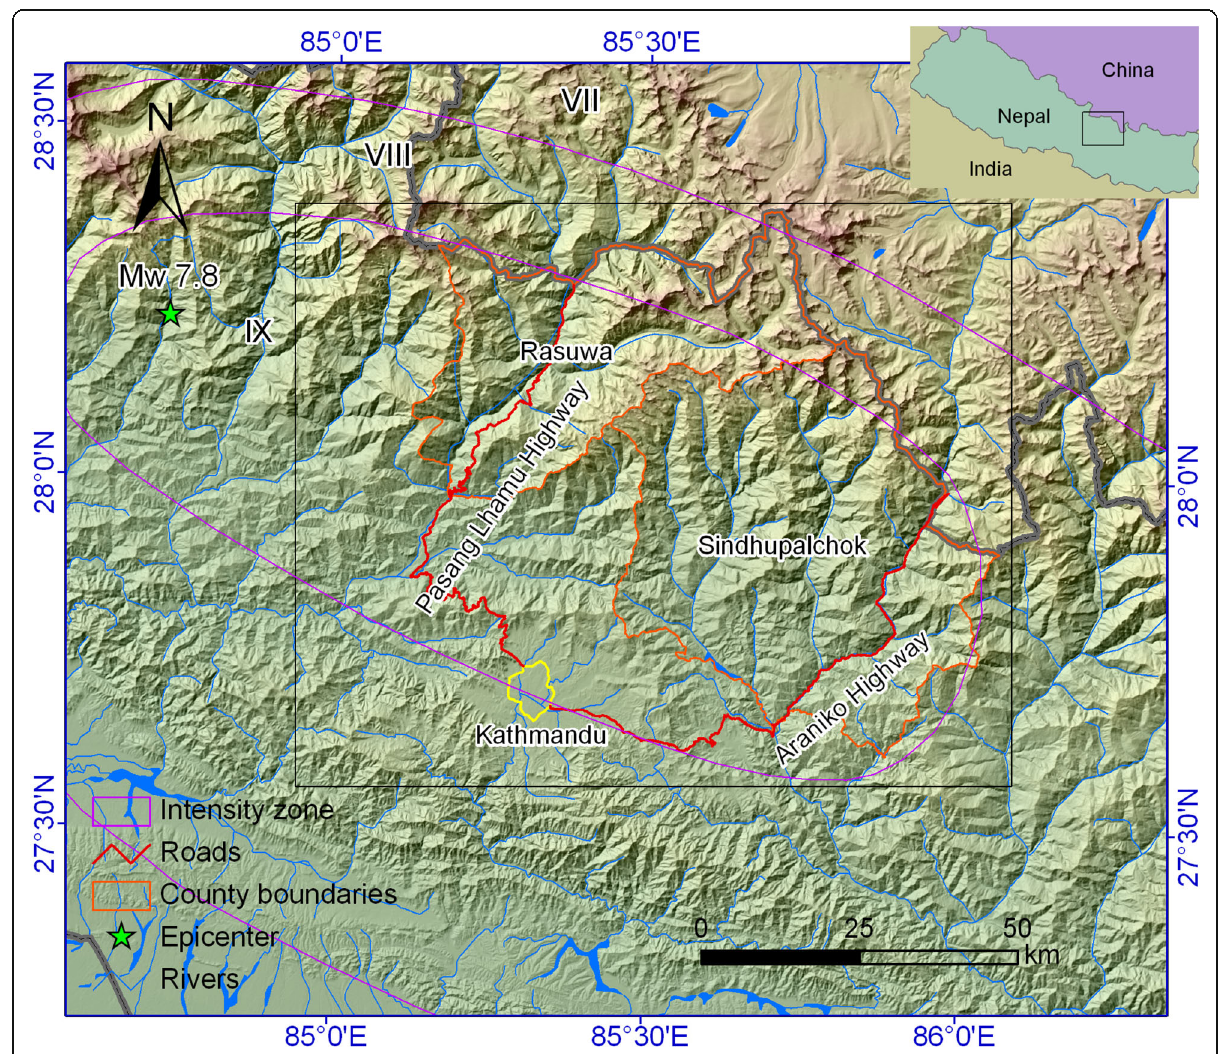
Fig. 1 Shaded topographic relief map showing the study area ( big black box ) and two